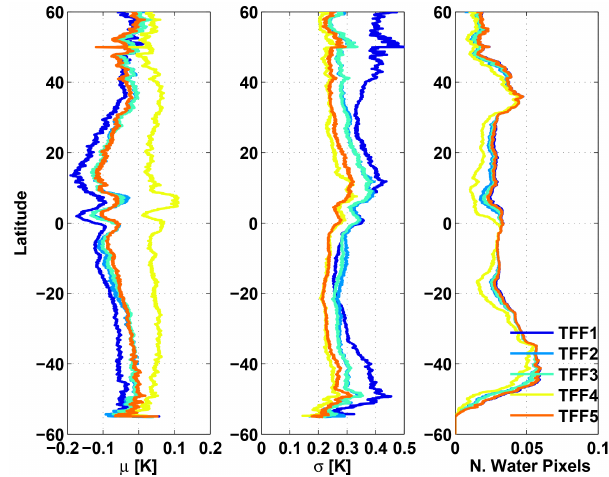
Figure 2. Latitude dependent statistics of TFF–VF for the period